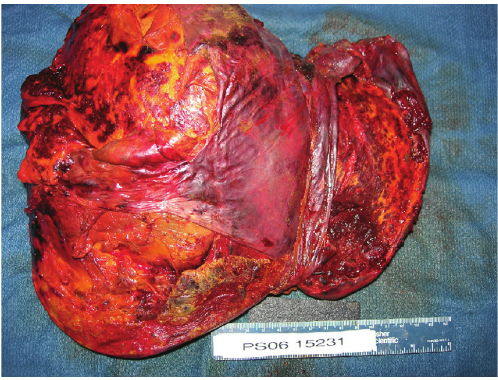
Figure 1: Native liver: 3000 g liver (expected weight 1500–1800 g) with dull yellow-green geographic necrosis and subcapsular blood.